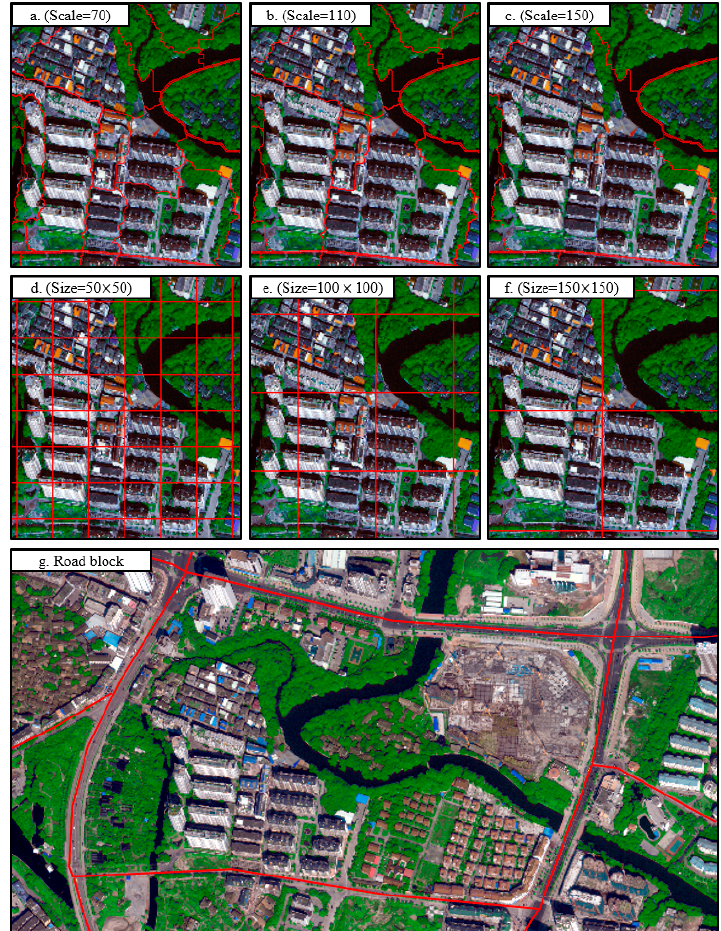
Figure 22. A comparison of: multiscale geoscenes ( a – c ); multiresolution image tiles ( d – f ); and road blocks ( g ). The geoscenes are generated at the scales of 70, 110, and 150, and the tiles are produced with the sizes of 50 50, 100 100, and 150 150 .